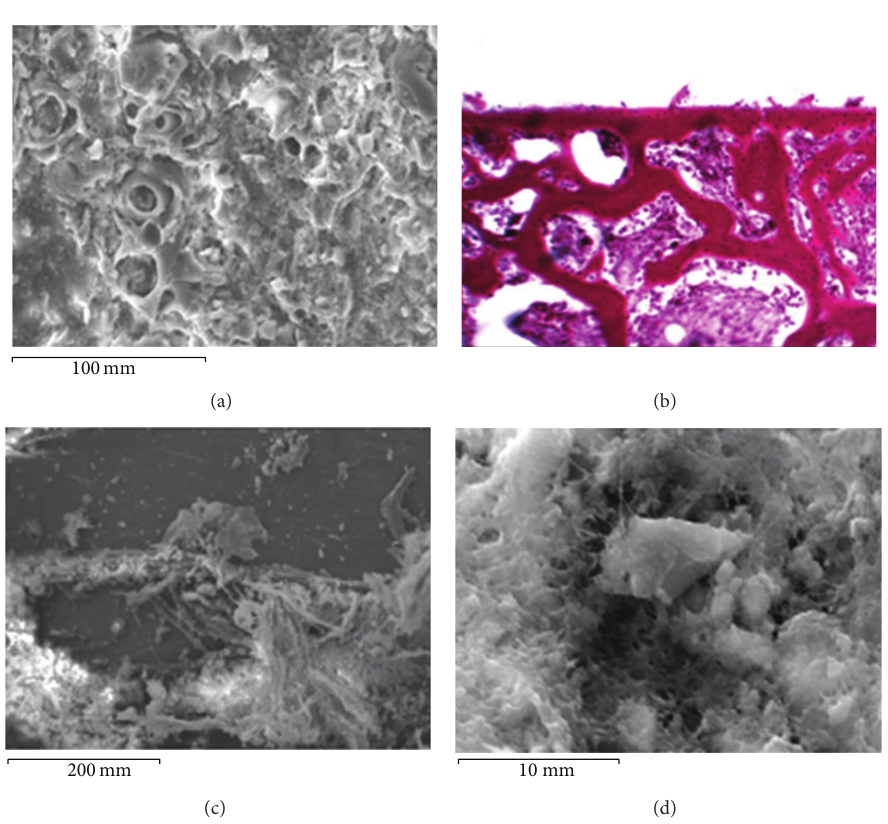
Figure 5: Structural features of the FIN wire surface and its adjacent area: (a) architectonics of the FIN wire, SEM × 1300; (b) osseoosteoid trabecular net envelope in the area adjacent to FIN wire, day 14, hematoxylin eosin staining, × 100; (c) fixation of collagen fibres of the osseoosteoid envelope to the rough FIN wire surface, day 14, SEM × 400; and (d) adhesion of osteogenic cells to the FIN wire surface and amorphous bone matrix in the pericellular space, SEM ×